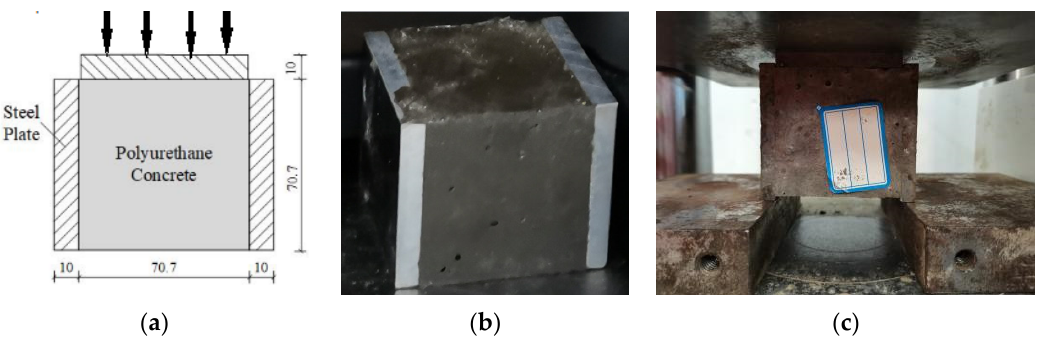
Figure 5. Test specimen of the bond strength test and test process. ( a ) Diagram; ( b ) Test Specimen ( c ) Test process.